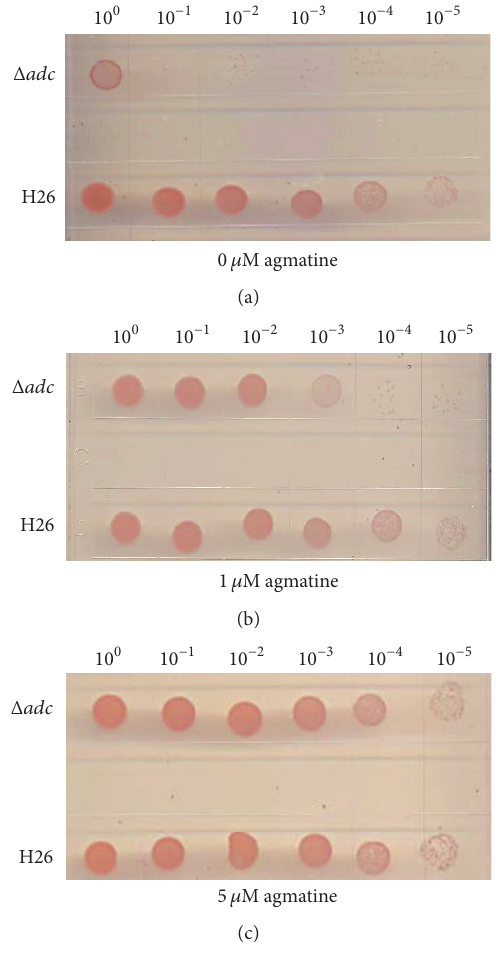
Figure 5: Agmatine is essential for the growth of the Hfx. volcanii Δ𝑎𝑑𝑐 strain. Hfx. volcanii H26 (WT, parent) and Δ𝑎𝑑𝑐 (HVO 1958) were diluted to an OD 600 of 1 and then spot-plated (15 𝜇 L) on solid agar Hv min medium in serial dilutions as indicated: (a) in absence of agmatine; (b) in presence of 1 𝜇 M agmatine; (c) in presence of 5 𝜇 Magmatine.Eachexperimentwasperformedwithtwobiological replicates and three technical replicates (for description of biological versus technical